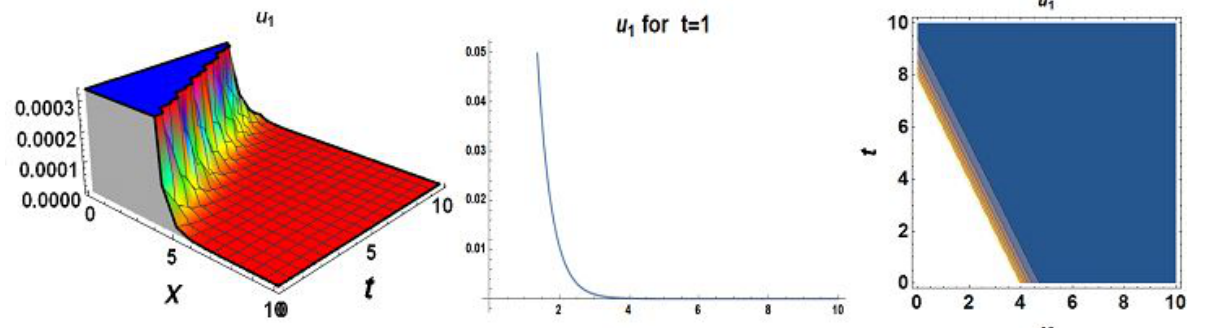
Figure 4: 3D,2D and contour graphics for A = 1, µ = −1, λ = −1, w = 1, k = 2 values of Eq.